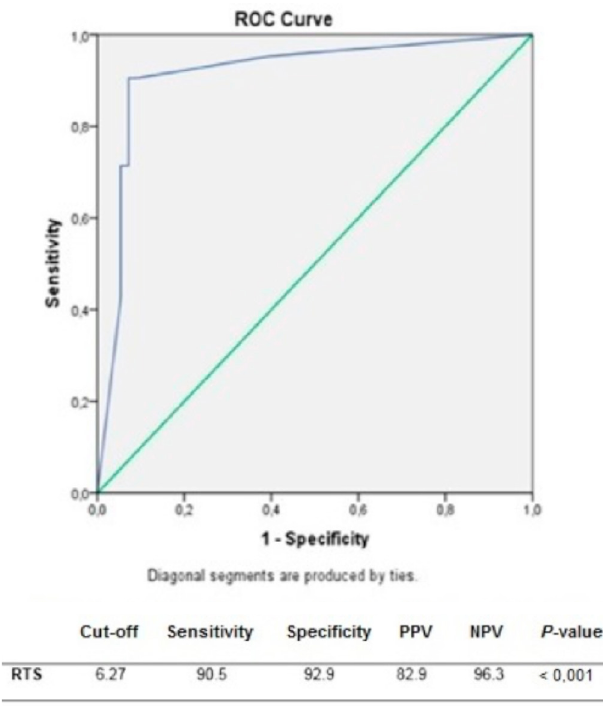
Fig. 2 – Receiver operating characteristic (ROC) analysis of RTS for the risk of mortality in cardiovascular injuries. Cut-off values of risk scores in the prediction of mortality. NPV=negative predictive value; PPV=positive predictive value; RTS=Revised Trauma Score.